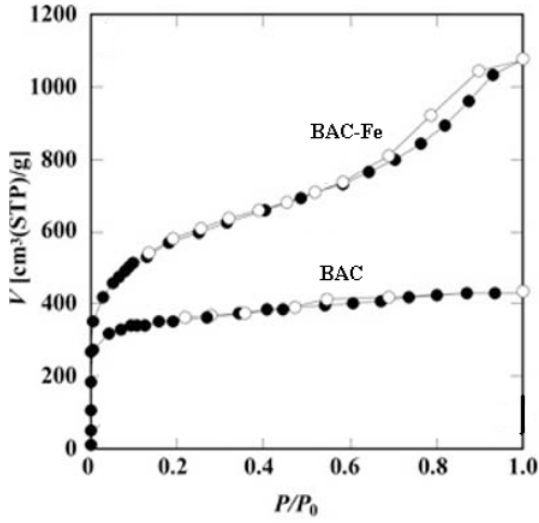
Figure 2. Isotherms of the adsorption of nitrogen at -196ºC for the synthesised sorbents. Table 2. Pore characteristics of the activated carbon samples.